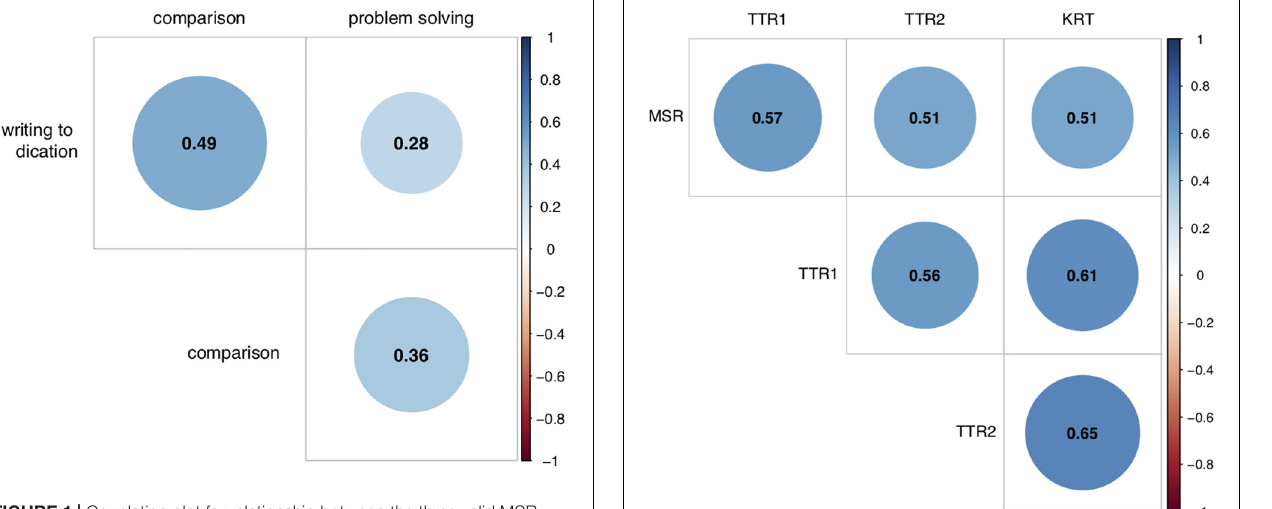
FIGURE 1 | Correlation plot for relationship between the three valid MSR tasks. Coefficients represent Pearson correlations. All significant at p < 0.001.